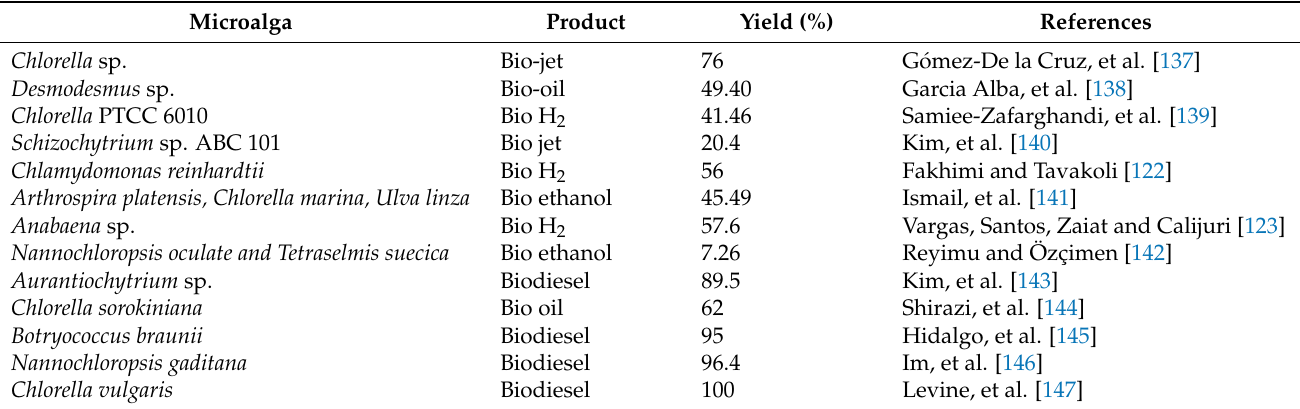
Table 4. Microalgae-based bioenergy